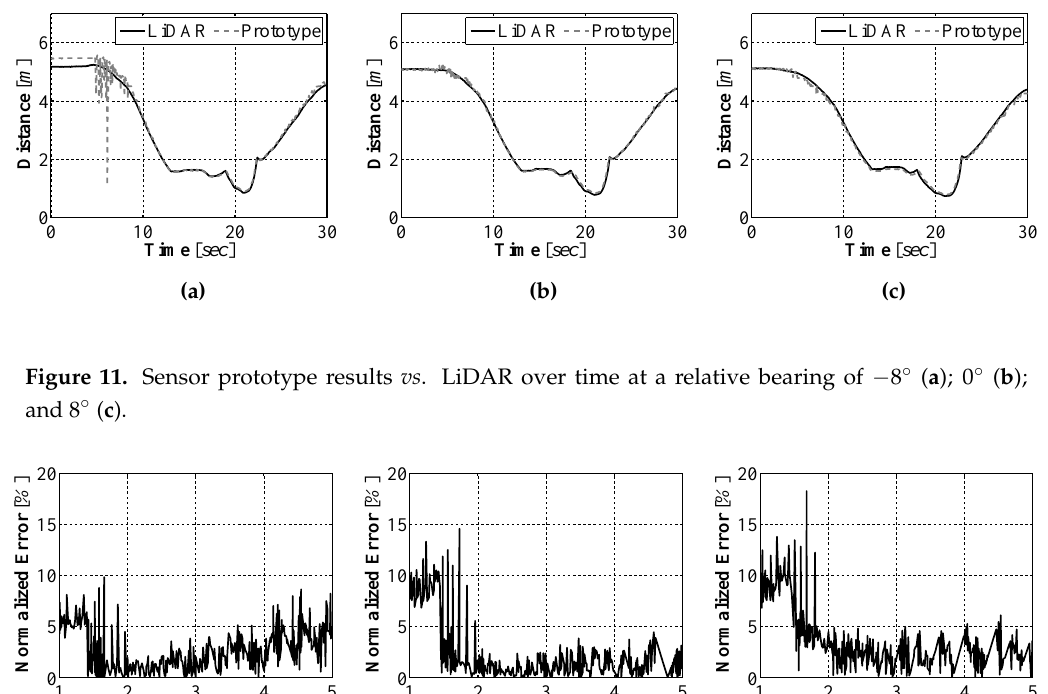
Figure 12. Sensor error as a function of distance at a relative bearing of